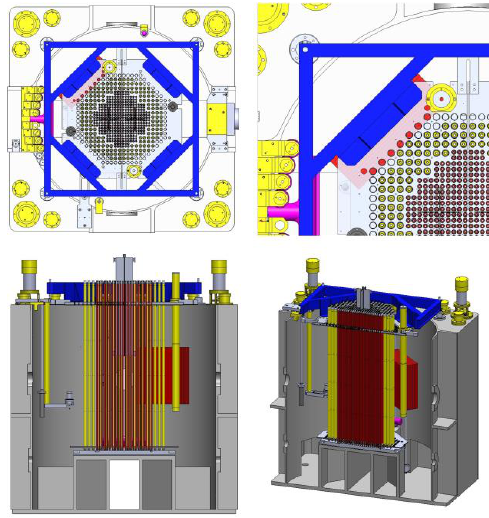
Fig. 2. Model of the metal reflector northwest positioning with respect to the core (top and side